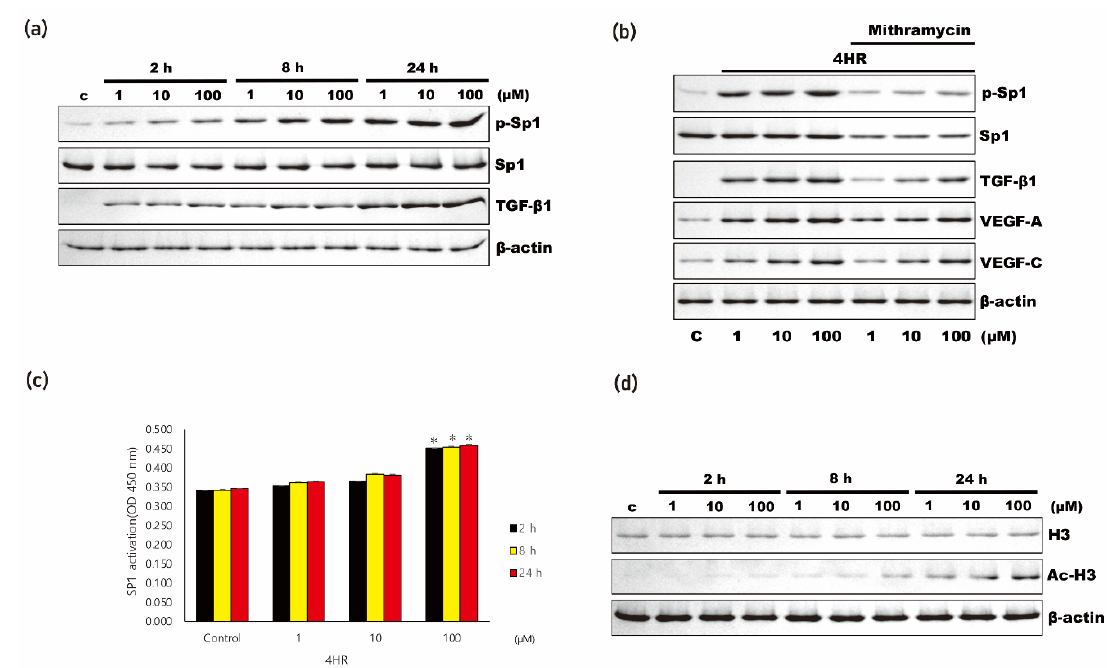
Figure 3. Sp1 and H3 acetylation by 4HR administration. ( a ) 4HR administration increased the expression level of p-Sp1 and TGF- β 1. ( b ) Mithramycin is an inhibitor of Sp1. The expression of Sp1-associated proteins was decreased by the administration of mithramycin. ( c ) The administration of 4HR increased Sp1 activity (* p < 0.05 compared to control). ( d ) 4HR administration increased the expression level of Ac-H3. All blots were performed in triplicate, and the statistical analysis of the relative expression level is shown in Supplementary Figure S8.